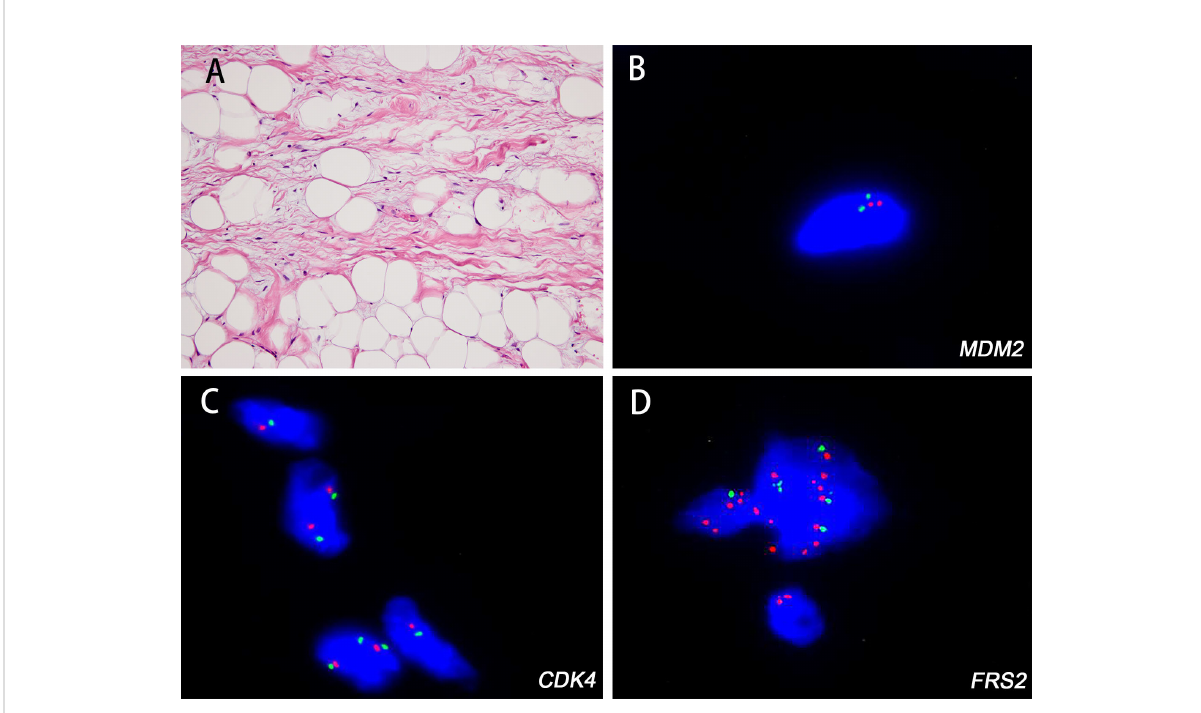
FIGURE 2 The histologic features of well-differentiated liposarcoma (WDL) with unusual genetic results and corresponding fl uorescence in situ hybridization (FISH) images. The WDL (case 4) showing hyperchromatic bizarre stromal cells ( A H&E; magni fi cation: 200×). FISH analysis revealed that the tumor was negative for MDM2 (B) and CDK4 (C) gene ampli fi cation but with FRS2 gene ampli fi cation (D)